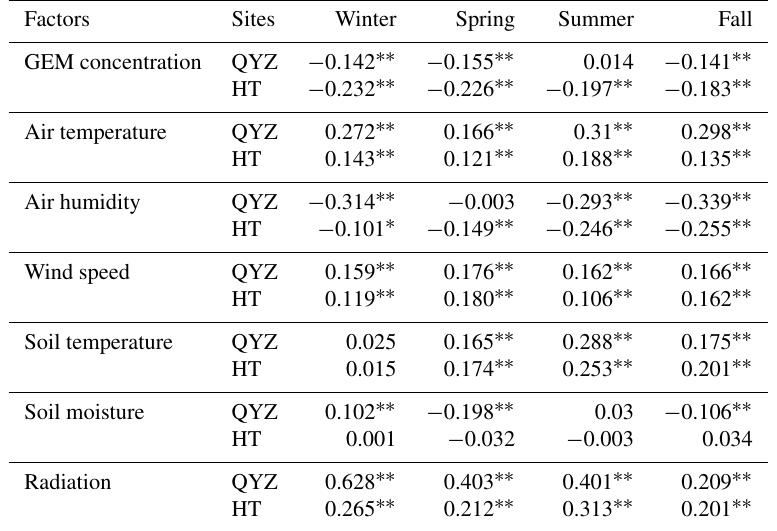
Table 2. Pearson’s correlation coefficient between GEM flux over forest canopy and atmospheric GEM concentration or each environmental factor.